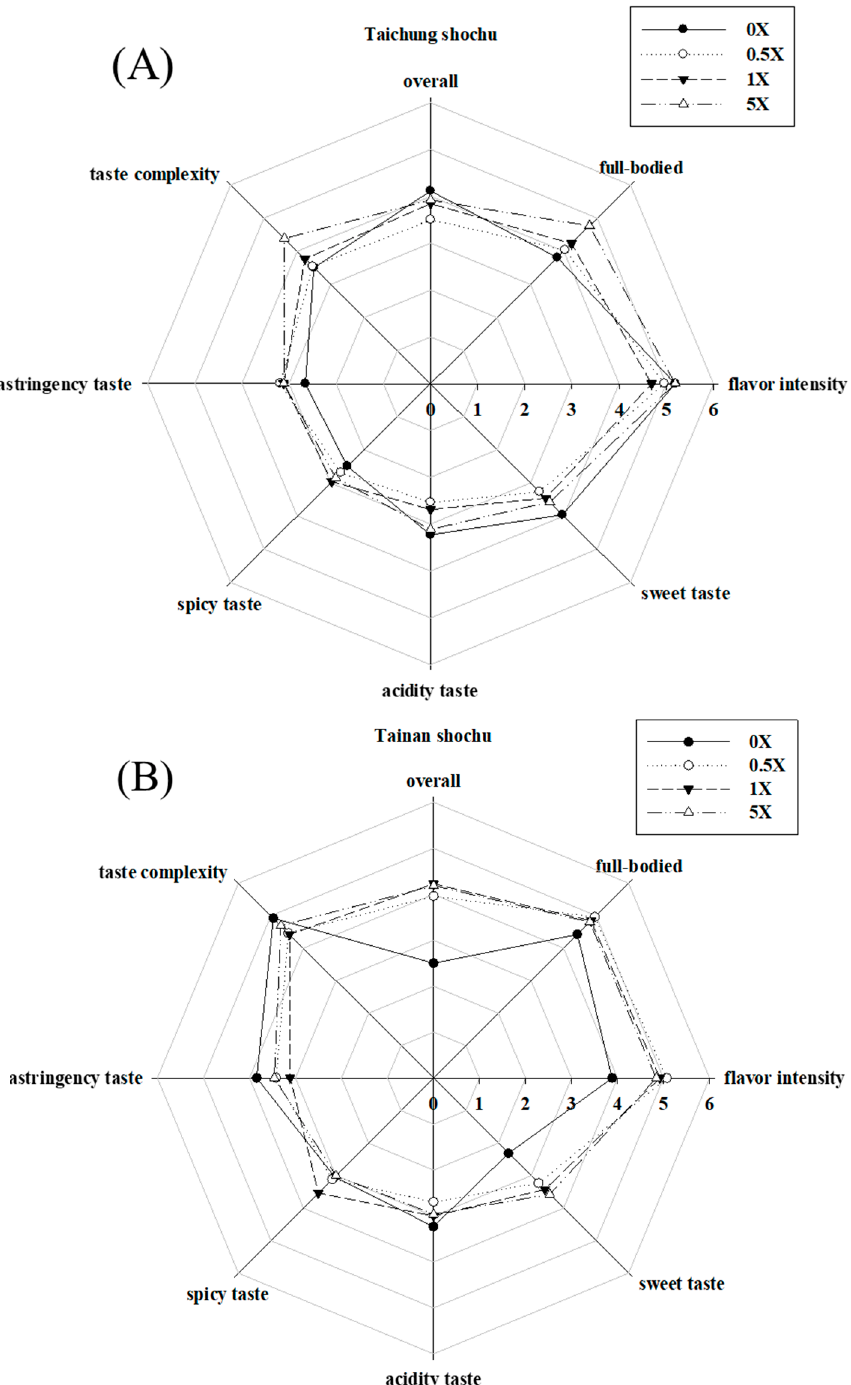
Figure 2. Sensory evaluation of rice shochu sample. Each value was expressed as the mean of evaluation scores ( n = 26). The results of Taichung No. 10 rice shochu ( A ) and Tainan No. 11 rice shochu ( B ) were brewed with DOWC with different concentrations.